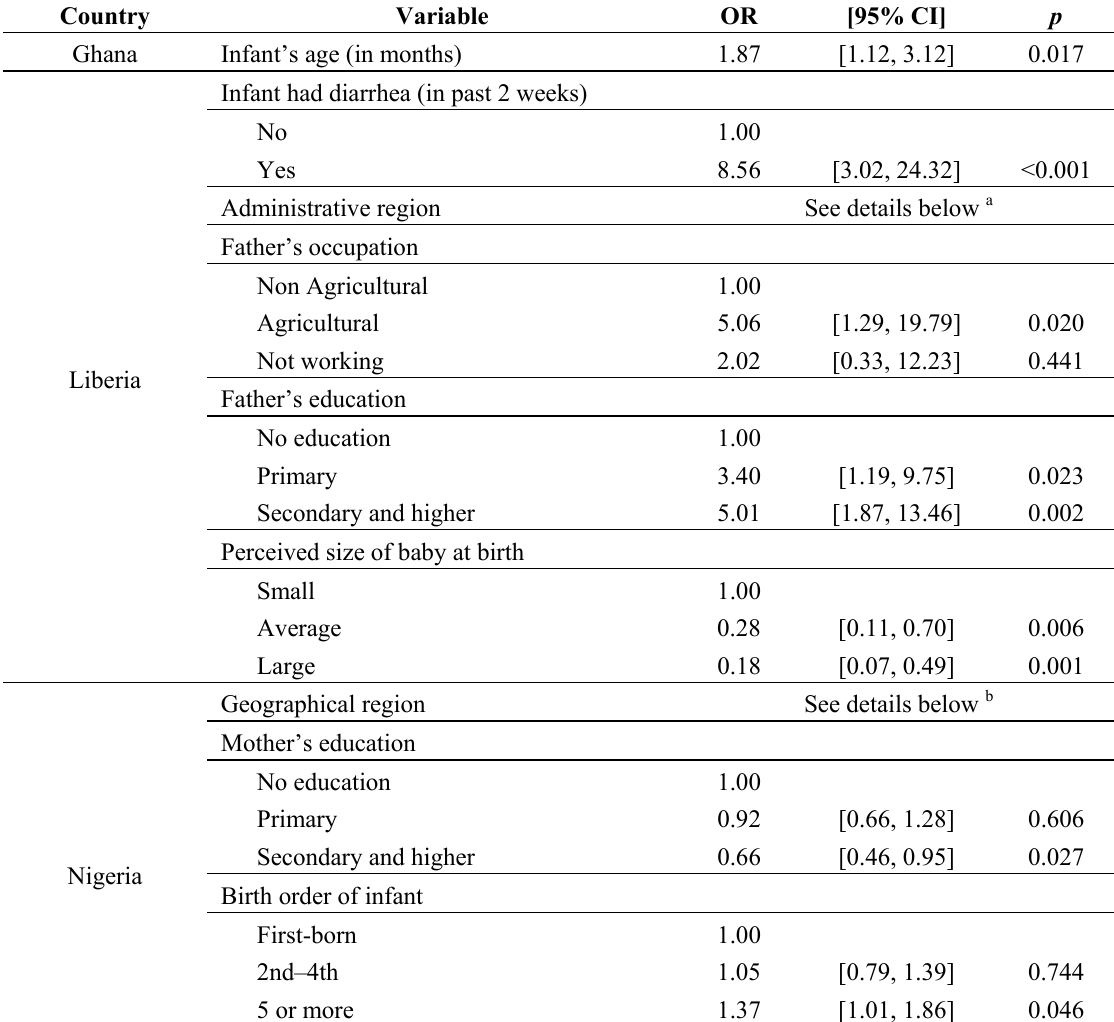
Table 3. Factors associated with early introduction of solid, semi-solid or soft foods among infants aged 3–5 months in four Anglophone West African countries, 2007–2013.